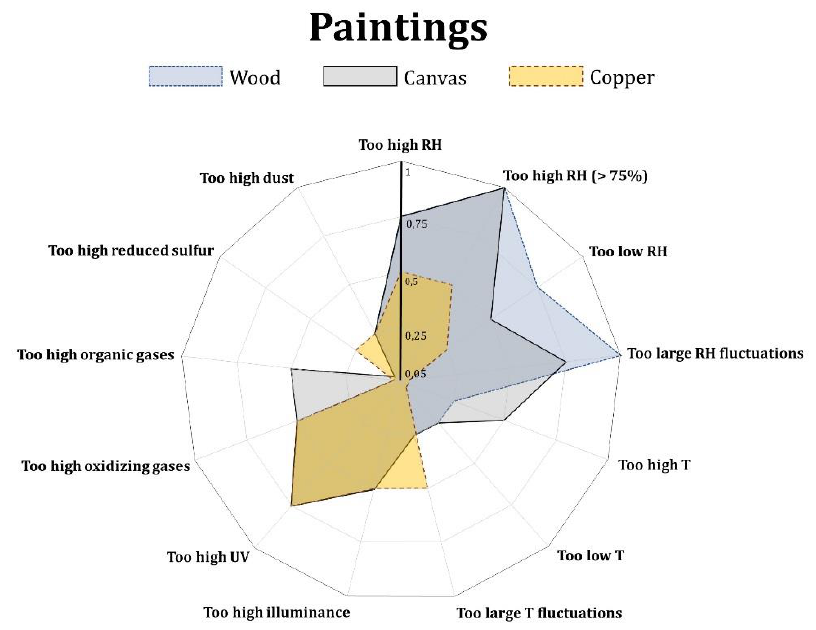
Figure 3. Spider plot with 13 dimensions to visualize the KRI importance for paintings on wood, canvas and copper. Five categories describe the impact on the degradation: negligible (0.05), low (0.25), moderate (0.5), high (0.75) and extremely high (1).